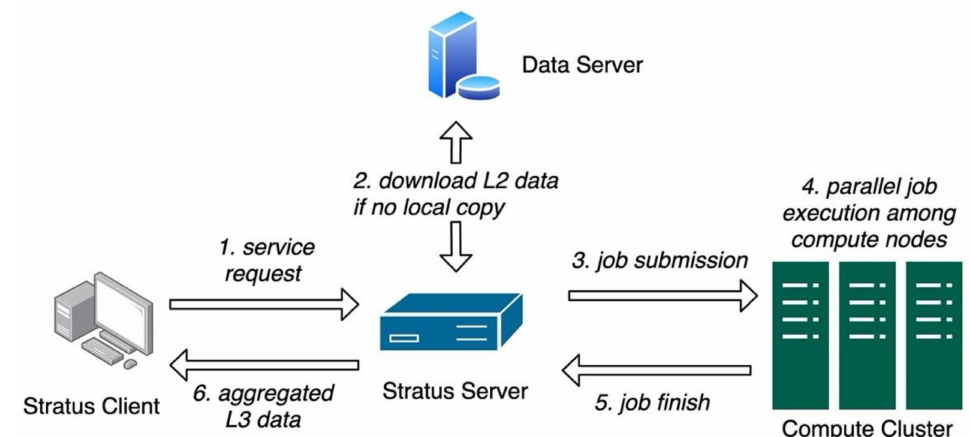
Figure 2. Integration of Stratus service framework with parallel MODIS aggregation.